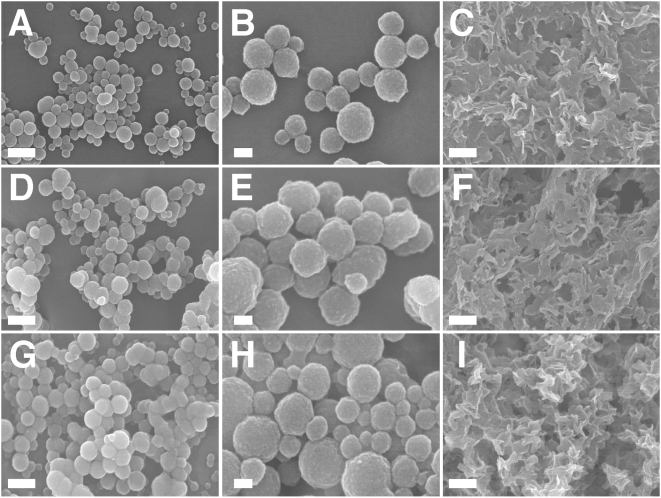
NLP associated with fetuin-A or albumin are morphologically similar.NLP were produced as described in Fig. 19, with 3 mM each of CaCl2, Na2CO3, and NaH2PO4 incubated with either 10 µM of BSF (A–C), 50 µM of HSA (D–F), or a combination of 10 µM of BSF and 50 µM of HSA (G–I). Incubation was done for 3 days (A, B, D, E, G, and H) or 1 week (C, E, and I) at room temperature. The initially clear solutions increased in turbidity with time, and by 3 days showed noticeable precipitation, which were then pelleted by centrifugation and washed with HEPES buffer once, followed by another wash with water, prior to SEM analysis. (B, E, and H) represent enlarged views of (A, D, and G), respectively. By one week of incubation, the round particles had coalesced to form films. Round particles or films seen with the 3 types of treatments appear virtually identical. Scale bars: 100 nm (B,D,F); 500 nm (A,C,E).